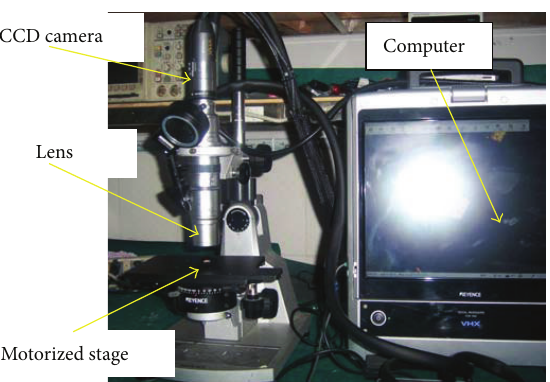
Figure 12: The VHX-600 digital